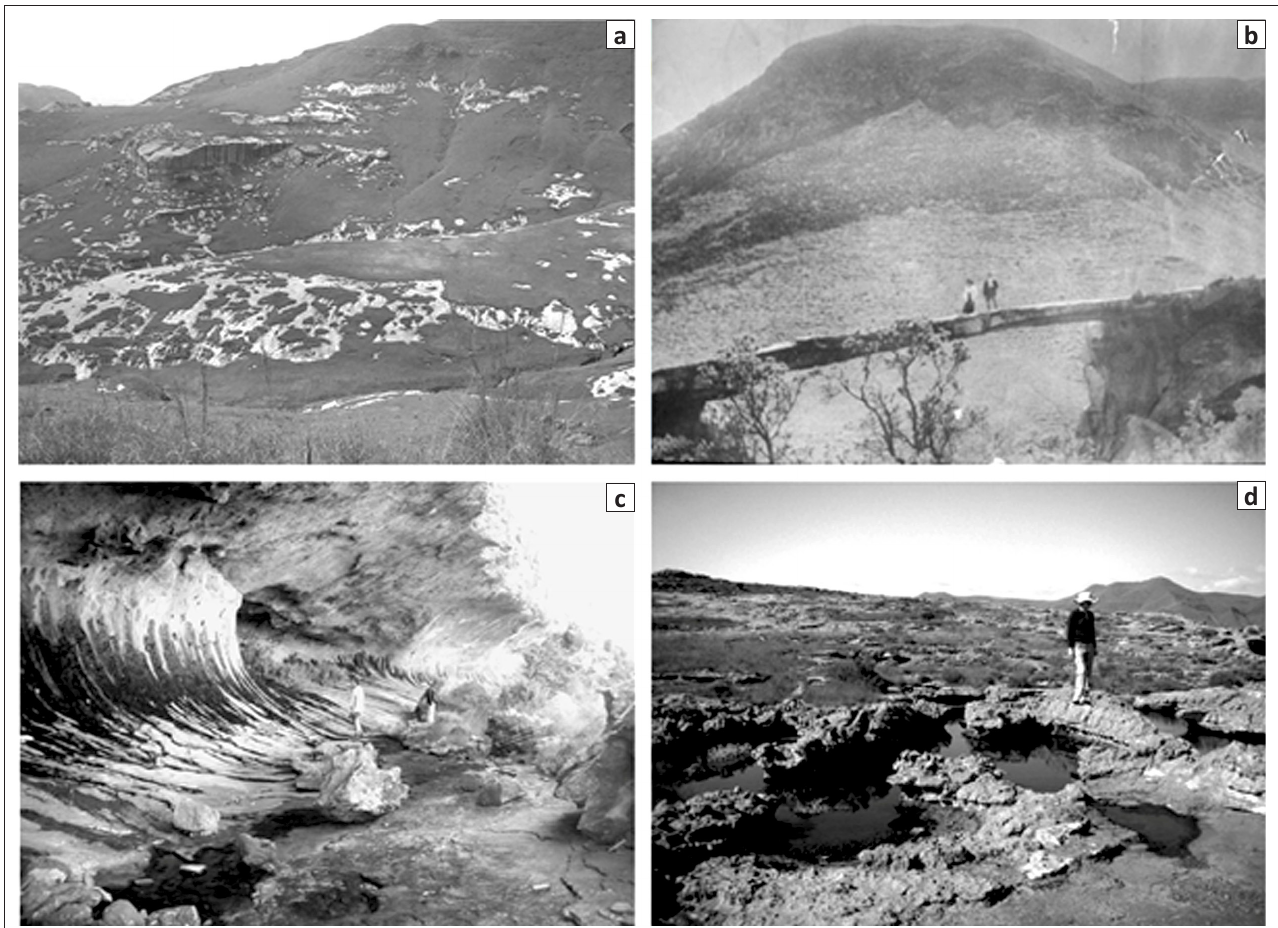
FIGURE 4: (a) ‘Vegetated islands’ overlying sandstone outcrops, (b) a natural stone bridge spanning the Zulu Hoek stream (since collapsed; electronic copy of original photo provided by Johan Taljaard, GGHNP), (c) water seepage and associated black staining at the rear of a cavern and (d) large rock basins with distinct water level